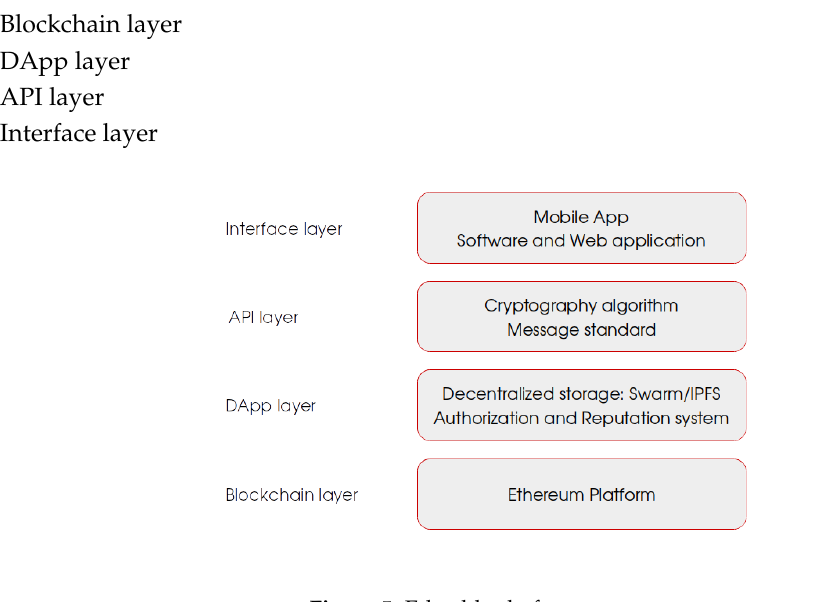
Figure 5. E-health platform